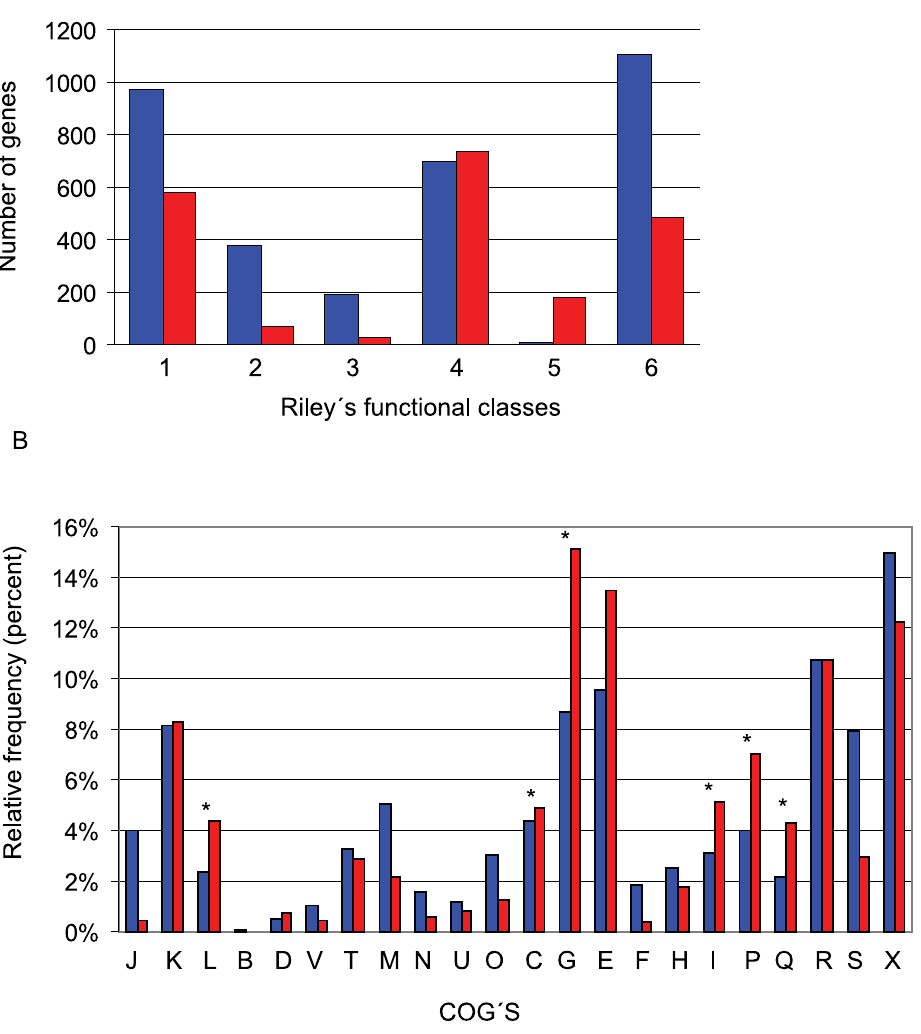
Figure 4. Functional bias in CHR-O (chromosomal only) and N-CHR (non-chromosomal) classes of homologues. - Figure 4a) Rileys categories: 1. small molecule metabolism. 2. Macromolecule metabolism. 3. Structural elements. 4. Cell process. 5. External origin. 6. Miscellaneous. 4b) COGs functional classification. Bars indicate the relative frequency for each COG J, Translation, ribosomal structure and biogenesis; K, Transcription; L, Replication, recombination and repair; B, chromatin structure and dynamics; D, Cell cycle control; V, Defense mechanisms; T, Signal transduction mechanisms; M, Cell wall, membrane envelope biogenesis; N, Cell motility; U, Intracellular trafficking and secretion; 0, Postranslational modification and chaperones; C, Energy production and conversion; G, Carhohydrate transport and metabolism; E, Amino acid transport and metabolism; F, Nucleotide transport and metabolism; H, Coenzyme transport and metabolism; I, Inorganic ion transport and metabolism; P, inorganic ion transport and metabolism; Q, Secondary metabolites biosynthesis, transport and catabolism; R, General function prediction; S, function unknown; X, No COG.